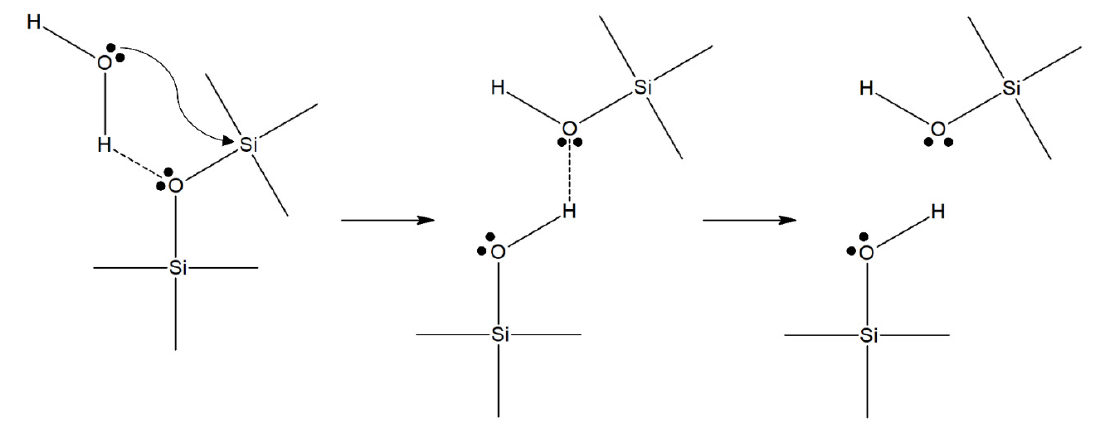
Figure 3. Hydrolytic degradation reaction of silica glass network, after [36].